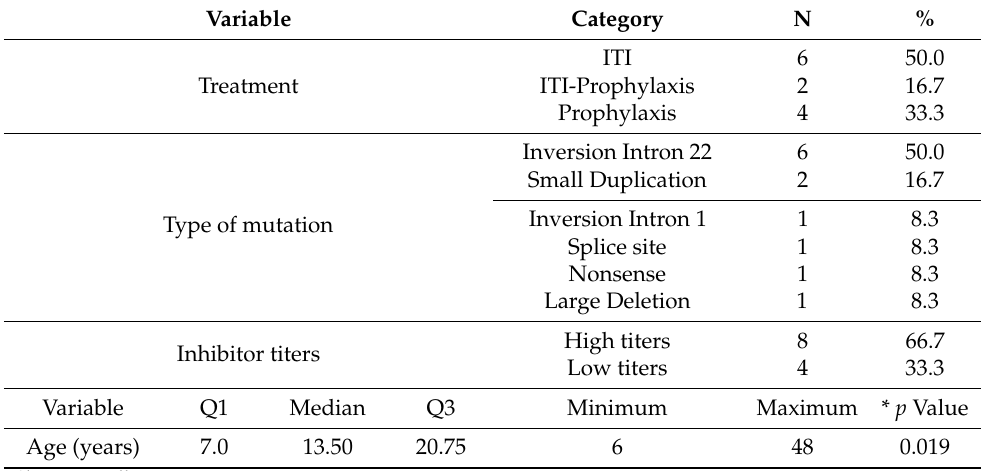
Table 1. Description of